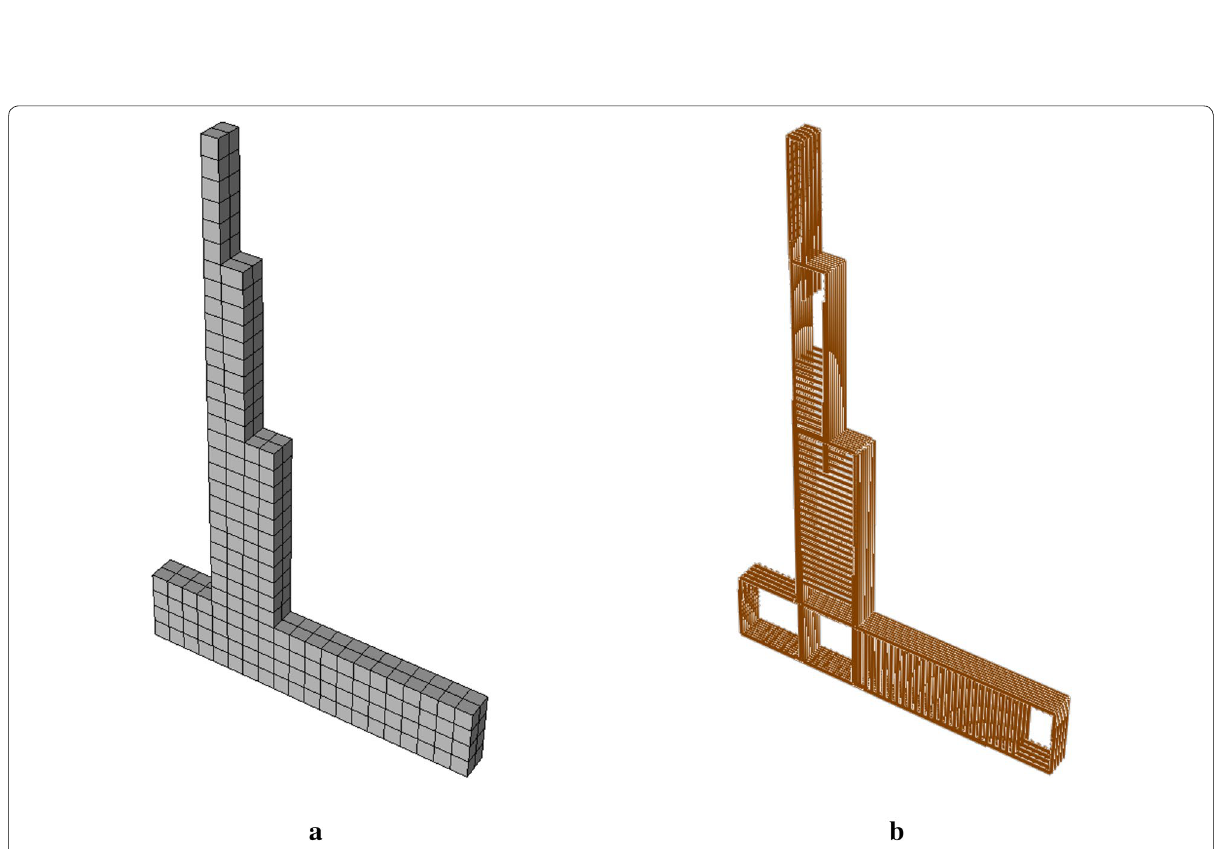
Fig. 16 Finite element model of the retaining wall: a C3D8T elements for concrete, and b T3D2 elements for the steel